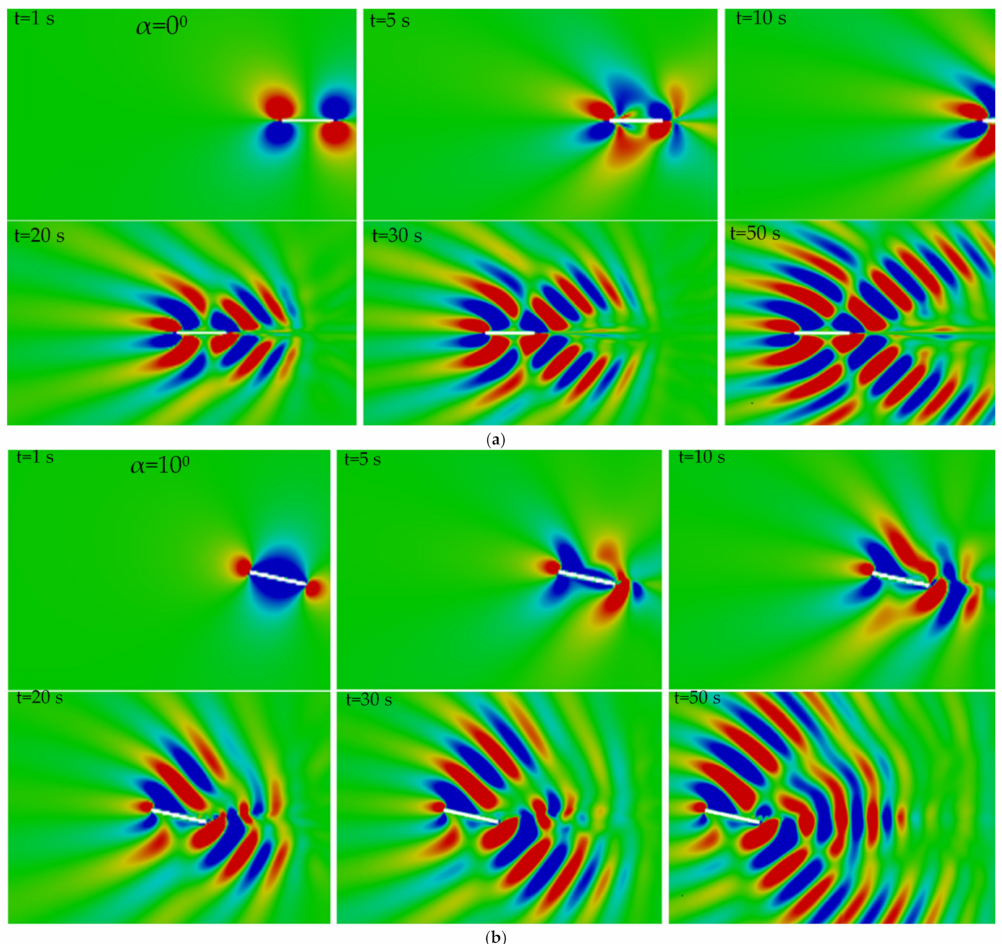
Figure 7. Evolution in time of internal wave patterns at impulse start of a horizontal ( a ) and a tilted ( b ) plate T b = 6.28 s, L = 10.0 cm, U = 1.0 cm/s, red and blue colors in the color spectrum correspond to positive and negative values of the vertical velocity component field within the range, − 0.25 < ν y < 0.25 cm/s, and green color is zero